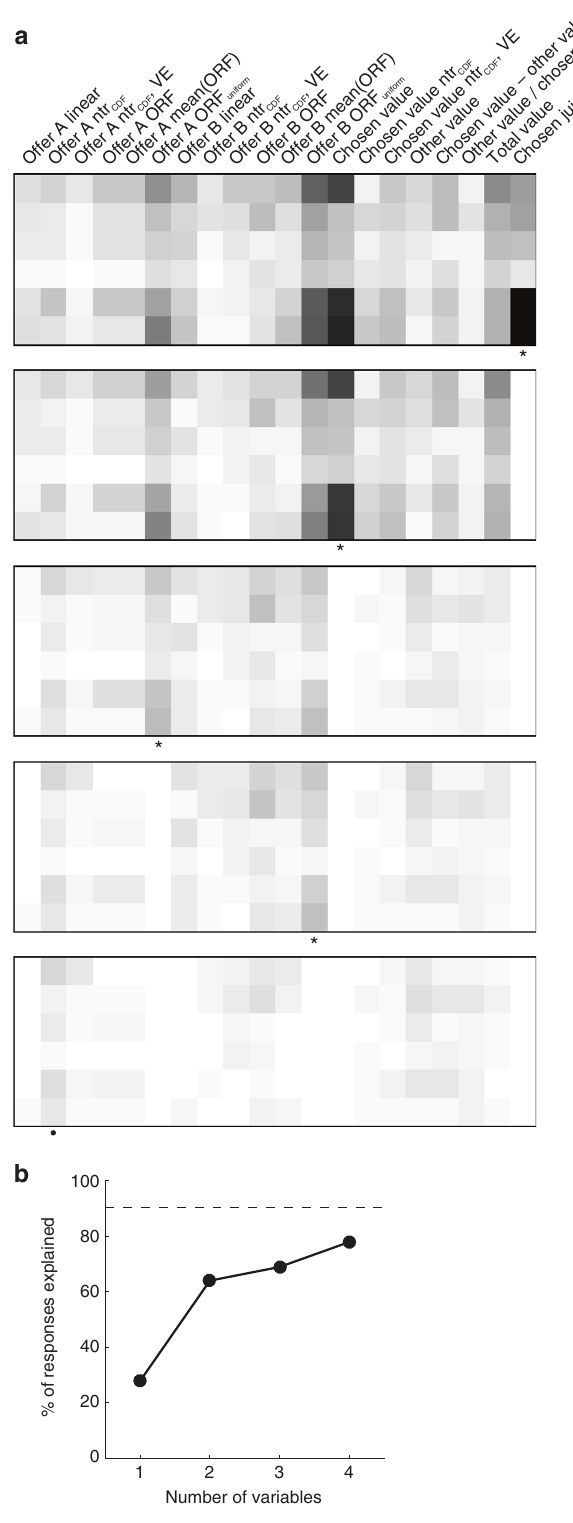
Fig. 9 Variable selection analysis. a Stepwise selection. The top panel is as in Fig. 8b. At each iteration, the variable providing the maximum number of best fi ts in a time window was selected and indicated with a * in the fi gure. All the responses explained by the selected variable were removed from the pool and the procedure was repeated on the residual data set. Selected variables whose marginal explanatory power was < 5% were eliminated (Methods) and indicated with a (cid:129) in the fi gure. In the fi rst four iterations, the procedure selected variables chosen juice, chosen value, offer A ORF uniform and offer B ORF uniform , and no other variables were selected in subsequent iterations. b Percent of explained responses. The y -axis represents the percentage of responses explained at the end of each iteration. The total number of task-related responses (1378) corresponds to 100%. The number of responses explained by at least one of the variables included in the analysis (1245/1378 = 90%) is indicated with a dotted